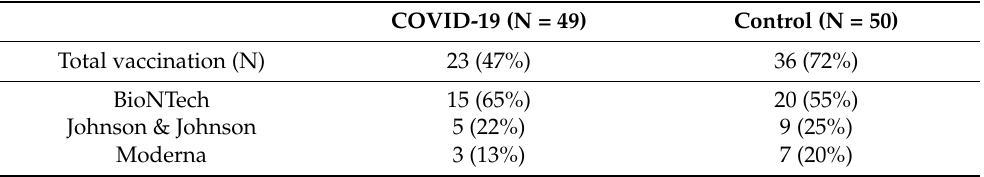
Table 2. Demographic data and some of the clinical parameters of subjects tested 300 days after the onset of COVID-19 infection. Table 3. Vaccination status of subjects in COVID-19 and control